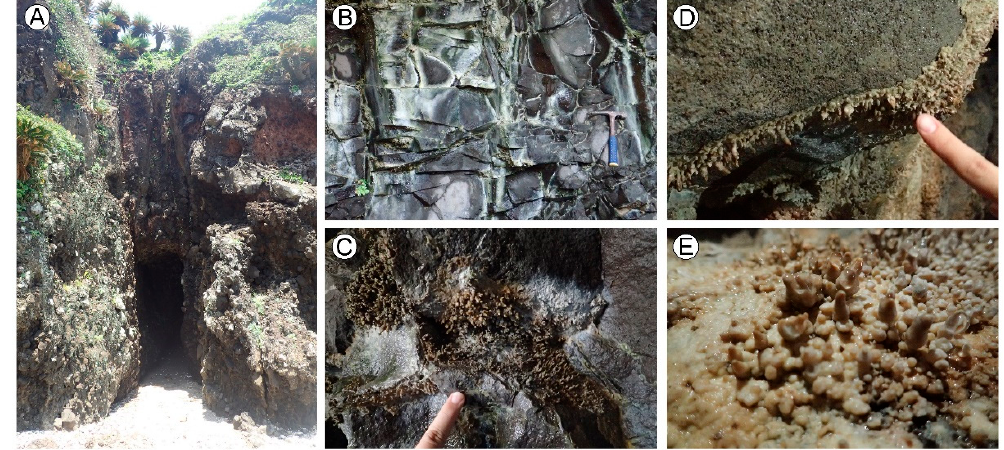
Figure 1. Outcrop of the tuff breccia in Aguni Island. ( A ) cave appearance; ( B ) cracking condition of the outcrop; ( C ) stalactite minerals along cracks; ( D , E ) stalactite minerals covering the surface of the host rock.